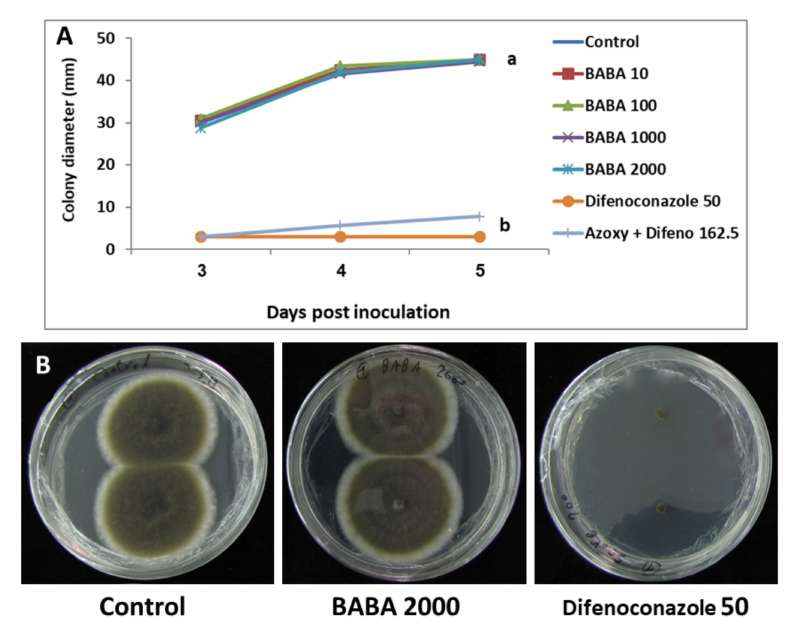
Figure 1. ( A ) Activity of BABA on mycelial growth of A. alternata f. sp. mali in comparison to difenoconazole (Difeno) and pre-mixture azoxystrobin plus difenoconazole (Azoxy + Difeno). Concentrations are given in µ g per ml active ingredient. Different letters on curves indicate a significant ( p < 0.05) difference between treatment (LSD test). ( B ) Activity of BABA and Score on mycelial growth of A. alternata f. sp. mali in PDA cultures. Concentrations are given in µ g per mL active